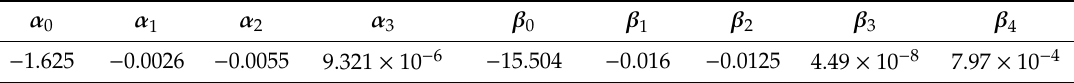
Table 2. Estimated model parameters used to remove the ionsopheric errors.